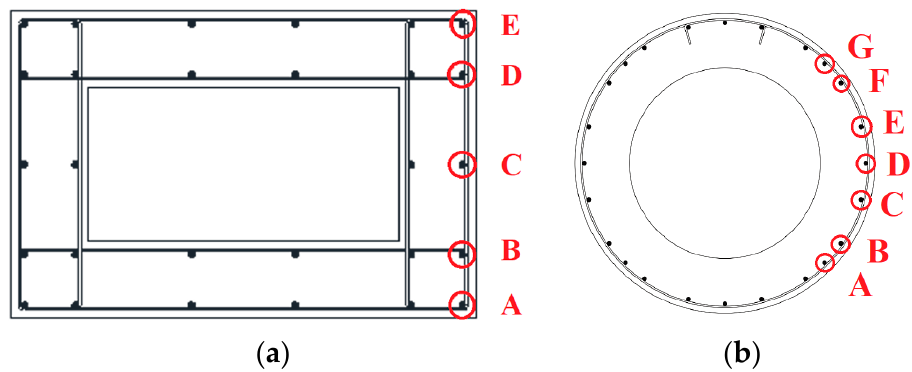
Figure 3. Corroded Bars (red circles): ( a ) rectangular and ( b ) circular hollow pier. In order to assess the evolution of the ageing process, non-destructive tests were carried out using the SonReb method and measurements of the corrosion potential, both in areas close to the corroded portion (e.g., measuring points 1B and 3B for rectangular pier), and, for control purposes, closer to the head of the pier stem (e.g., measuring points 1A and 3A for rectangular pier) (Figure 4a).